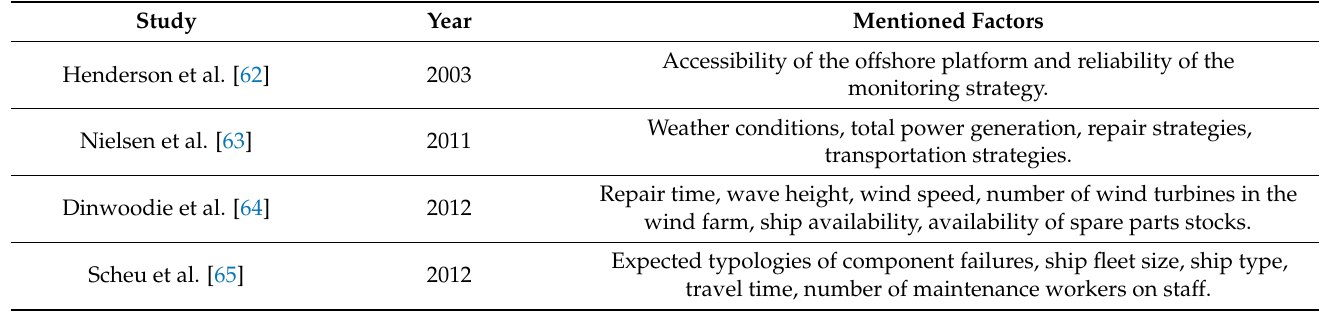
Table 4. Main factors influencing the choice of the maintenance strategy for offshore wind